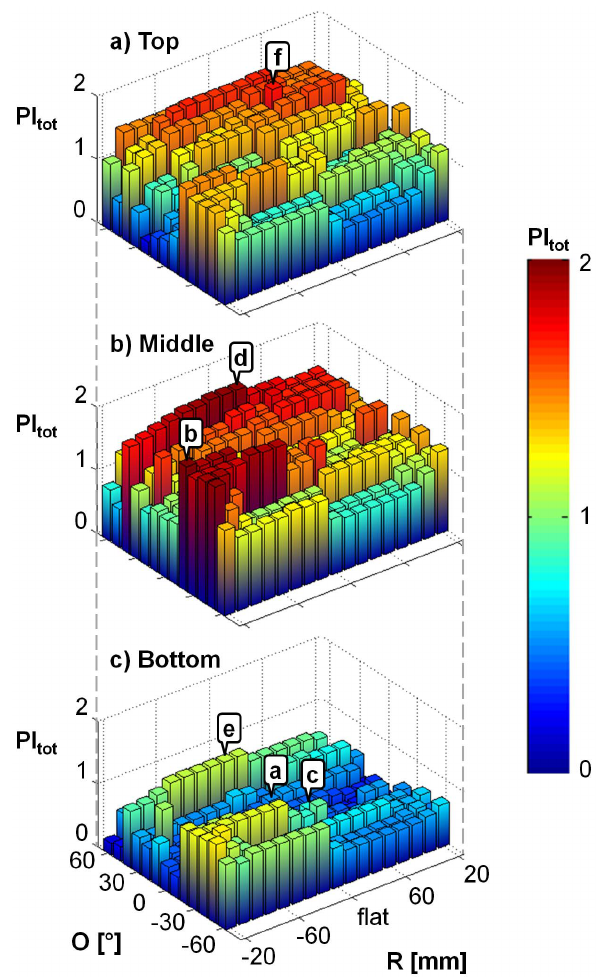
Figure 5. Total performance index results with respect to the different levels of keyboard radius of curvature (R) and keyboard orientation (O) for the (a) top, (b) middle and (c) bottom keyboard locations (L). Each bar on the graphs corresponds to the performance index for a different design. Data points identified by letters correspond to the highlighted designs presented in Figure 6 and discussed in the text.